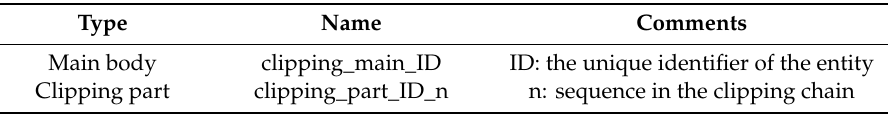
Table 2. Naming rules for main body and clipping part.